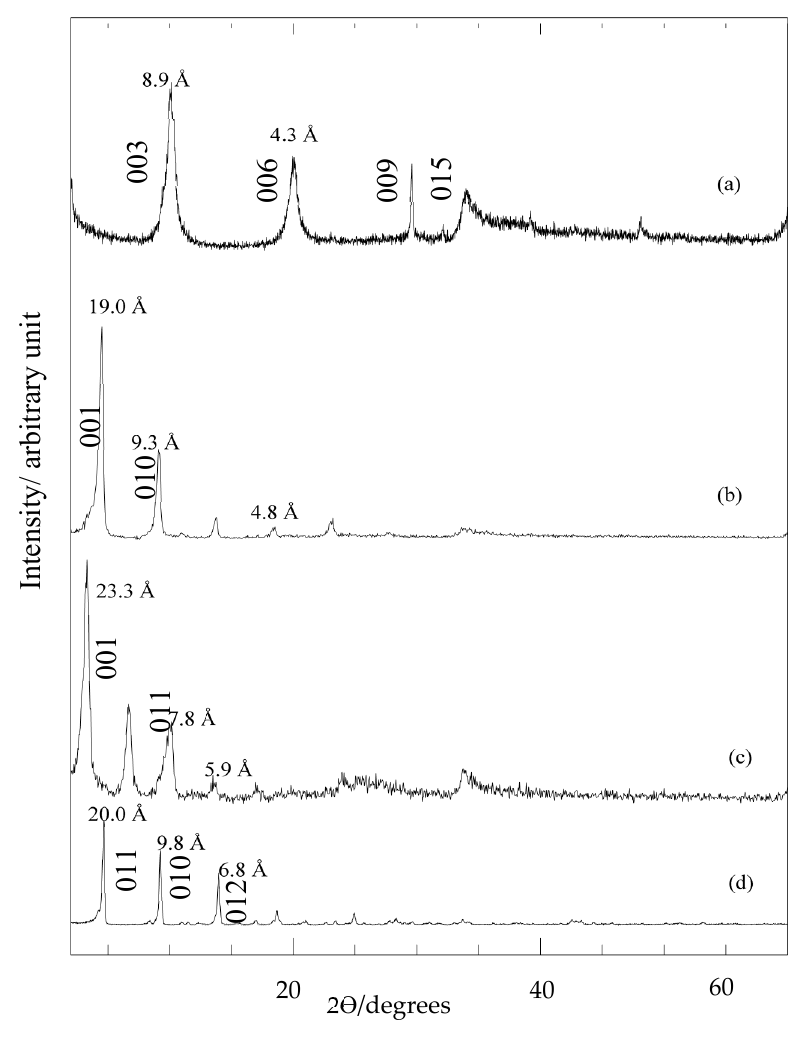
Figure 1. PXRD patterns of ( a ) LDH, ( b ) nanohybrid intercalation with single anion, 3,4D (ZAMDX) and ( c ) TBA (ZATX) and ( d ) nanohybrid containing both anions, 3,4D and TBA (ZADTX).